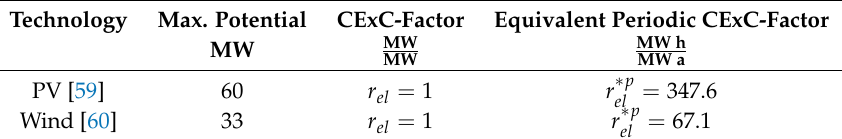
Table 6. Considered variable RES.